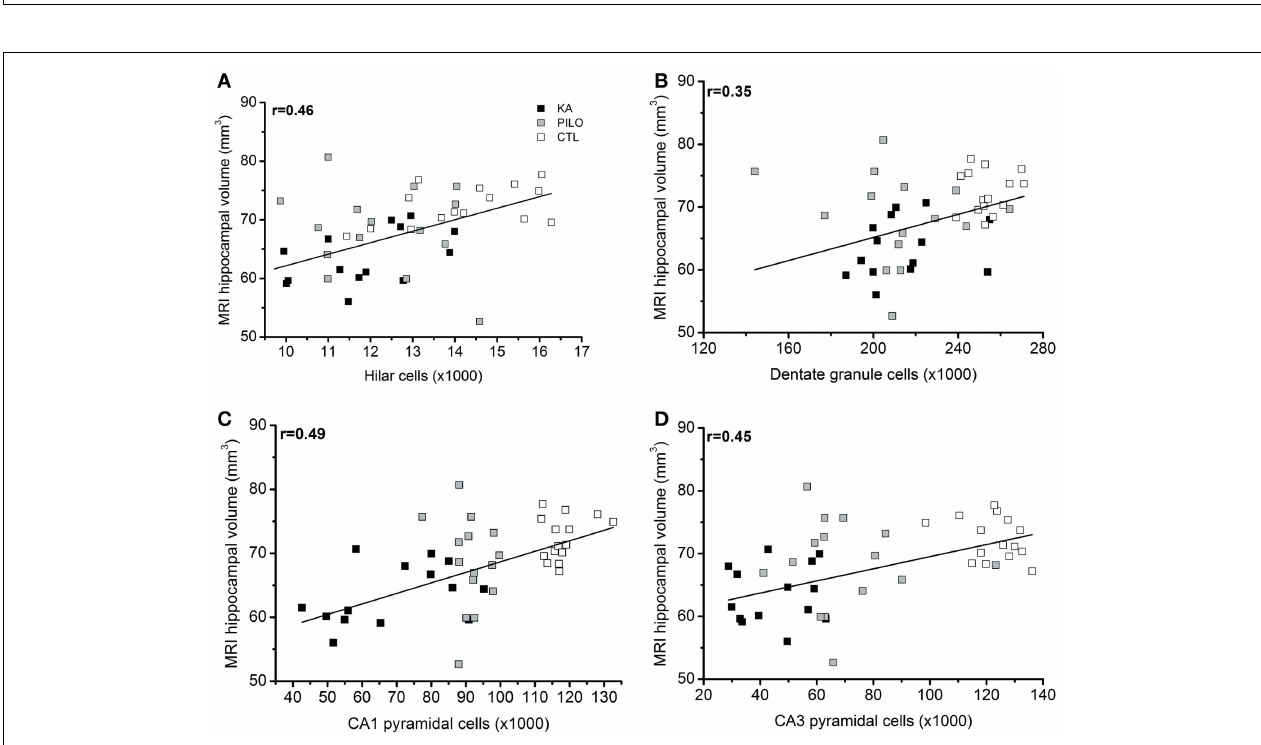
FIGURE 5 | Cavalieri probe hippocampal volume correlations. (A) Cavalieri probe hippocampal volume ( x axis) and number of cells ( y axis, × 1000) correlation for pooled time groups [ r = 0.49; P = 0.00069]. In (B) , the correlation between MRI volumetric values ( y axis) and Cavalieri probe analysis is shown ( x axis) ( r = 0.72; P = 0.00001).